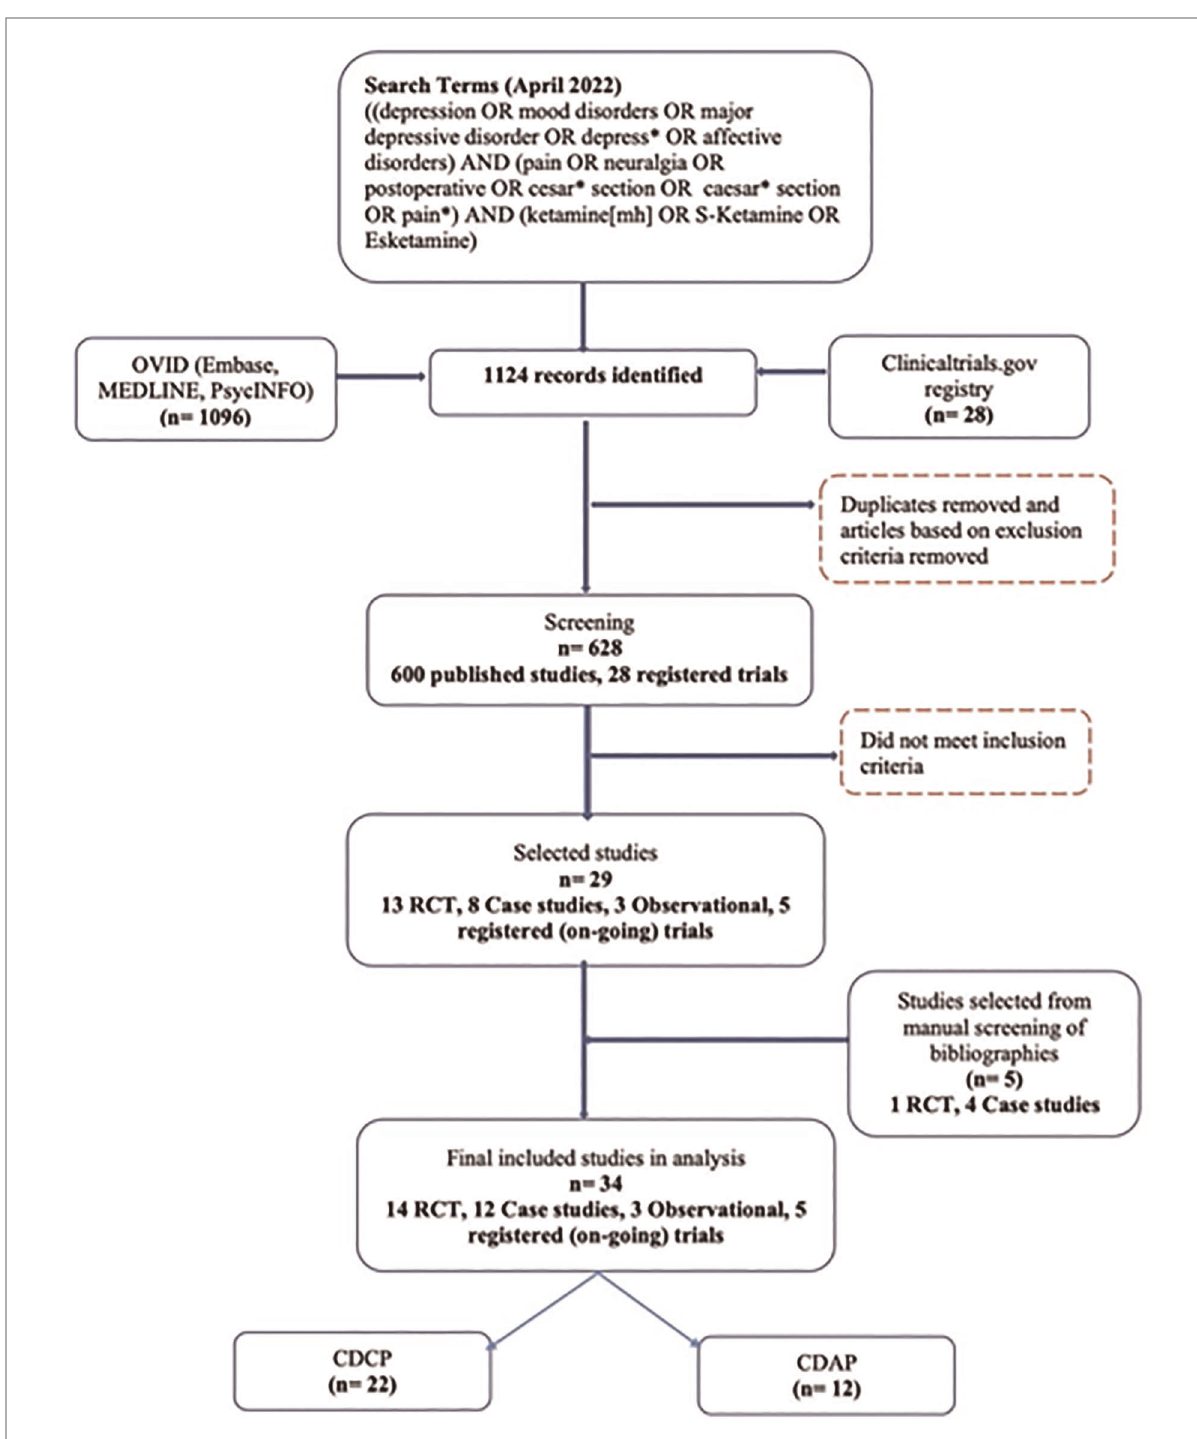
FIGURE 1 PRISMA fl ow chart re fl ecting the search strategy and screening process of published studies and registered (i.e., ongoing and planned) clinical trials included in the systematic review. CDAP, comorbid depression and acute pain; CDCP, comorbid depression and chronic pain; RCT, randomized- controlled